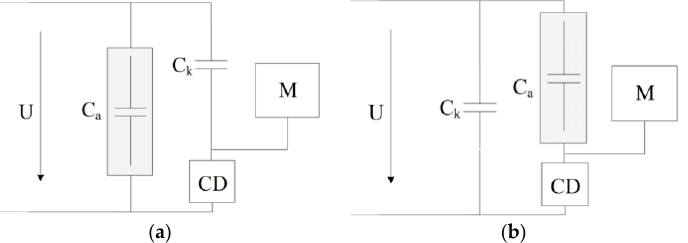
Figure 15. Typical pulse current method PD measurement circuit: ( a ) the coupling device is con- nected in series with the coupling capacitor; ( b ) the coupling device is connected in series with the test